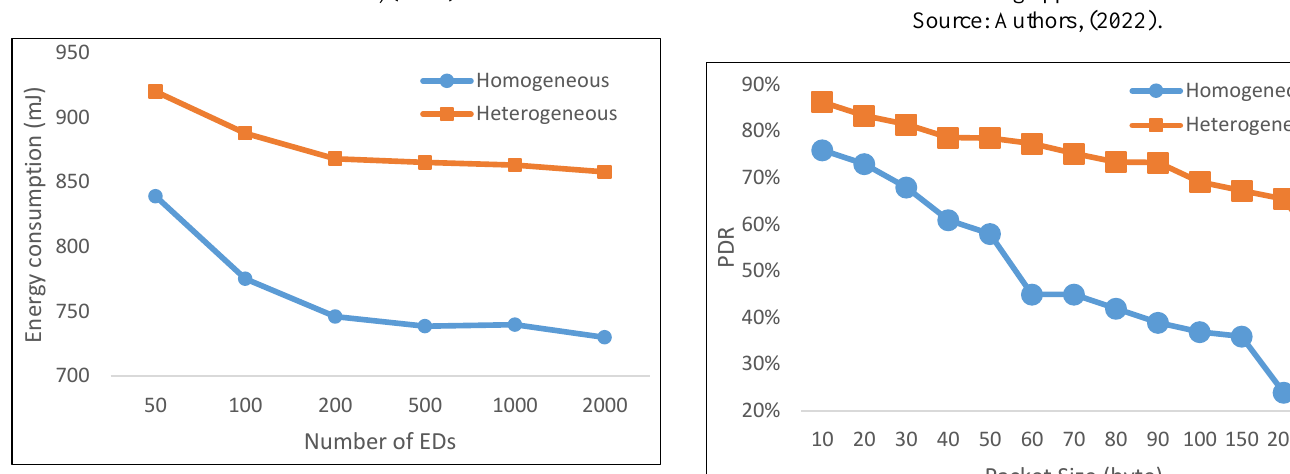
Figure 10: Time on Air for low, medium, and high reliability demanding applications.